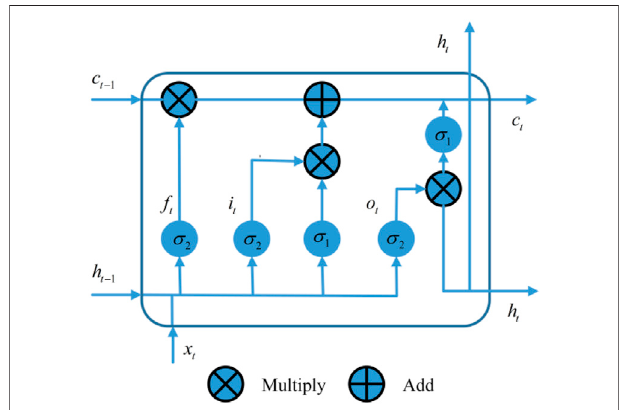
FIGURE 1 | Long short-term memory network structure.